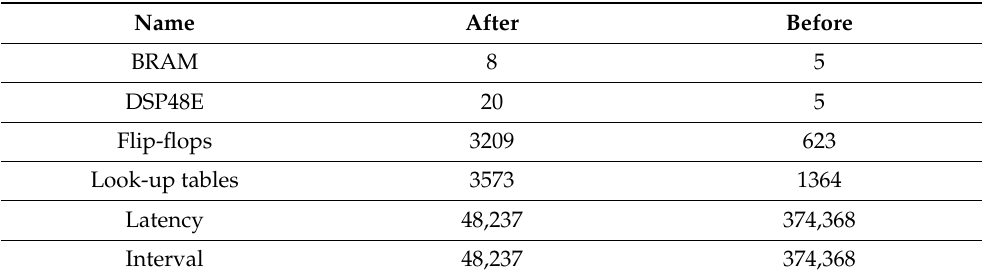
Table 3. The utilization of convolution computing function before and after optimizing.